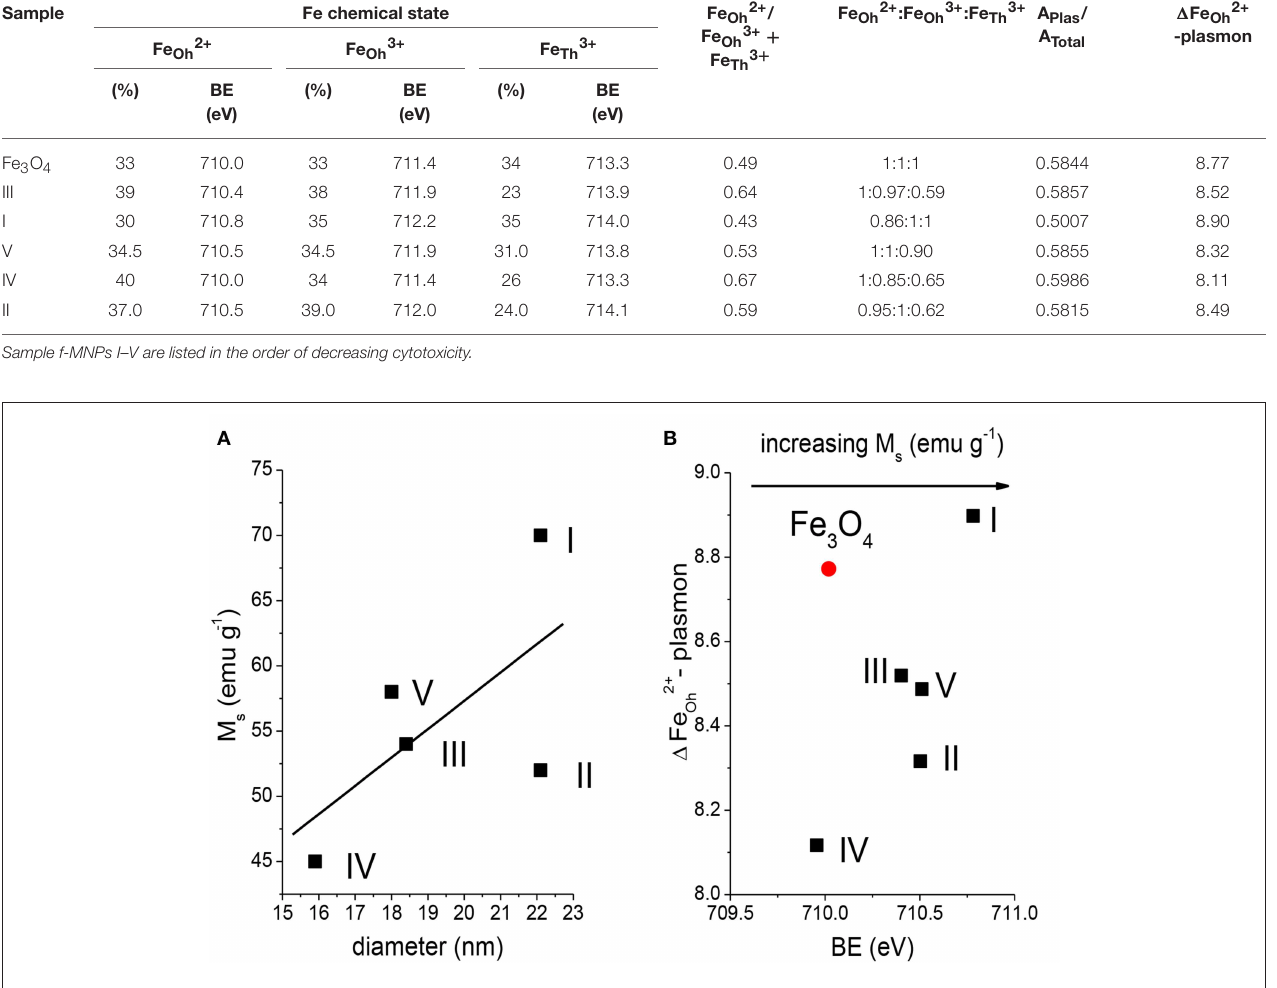
FIGURE 6 | Dependence of (A) Fe 3 O 4 f-MNPs I–V diameters determined from XRD (Rangam et al., 2017) as a function of saturation magnetization. (B) BE of Fe 2p 2 + octahedral component on separation between Fe 2p 3 / 2 2 + octahedral component and plasmon loss in Fe 2p 3 / 2 spectra recorded from Fe 3 O 4 MNPs